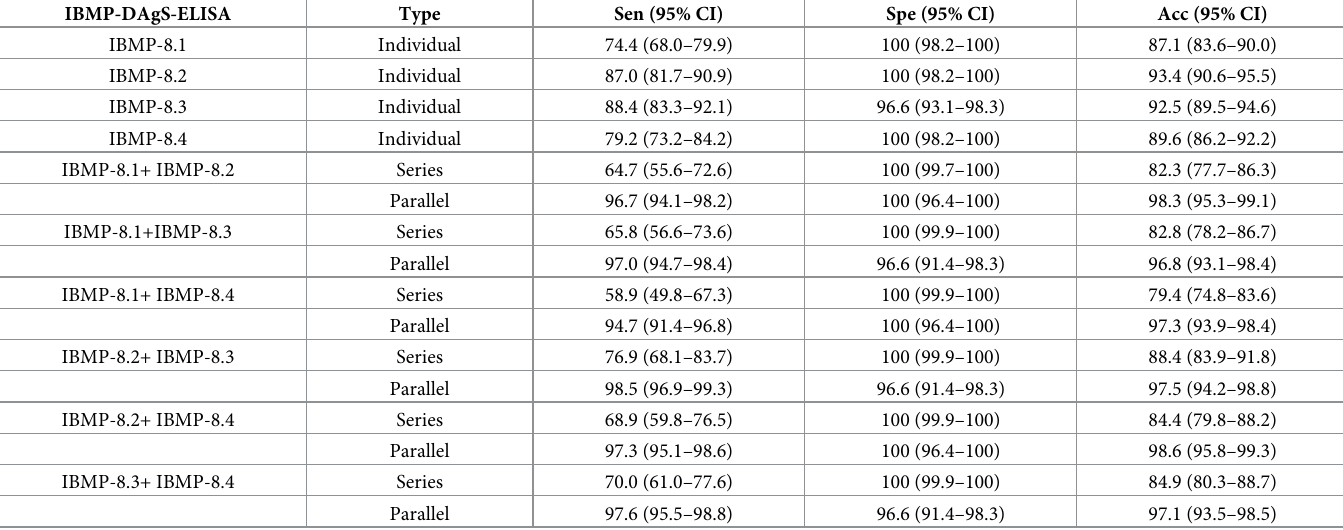
Table 1. IBMP-DAgS-ELISA diagnostic test assay results compared both individually and under several combinations of IBMP chimeras; additional analysis per- formed using series and parallel